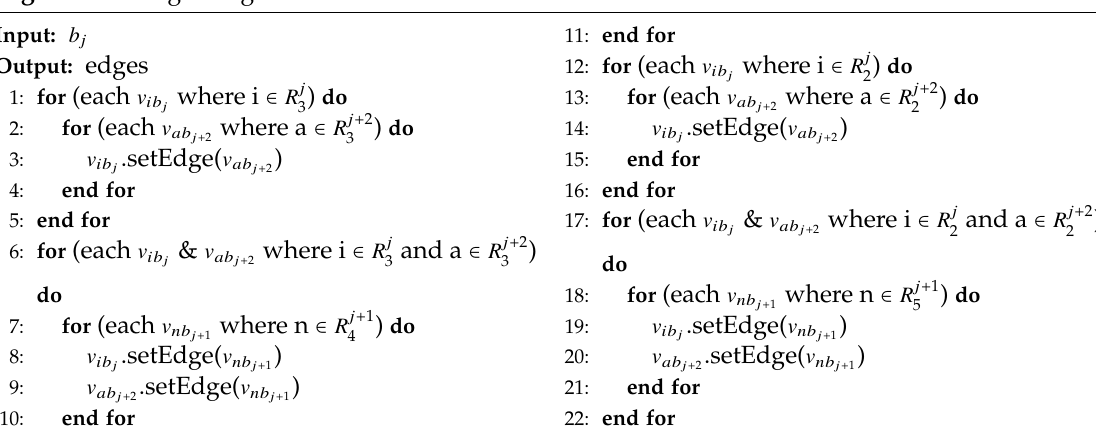
Algorithm 3 Edge assignment to the nodes